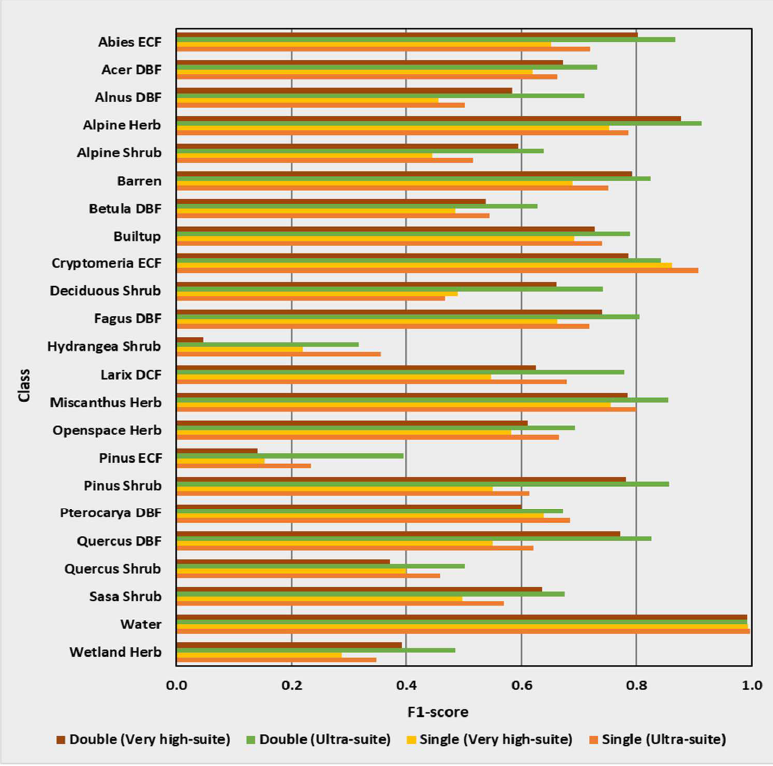
Figure 13. Class-wise changes in accuracy (F1-score) by addition of summer images in the Zao site.